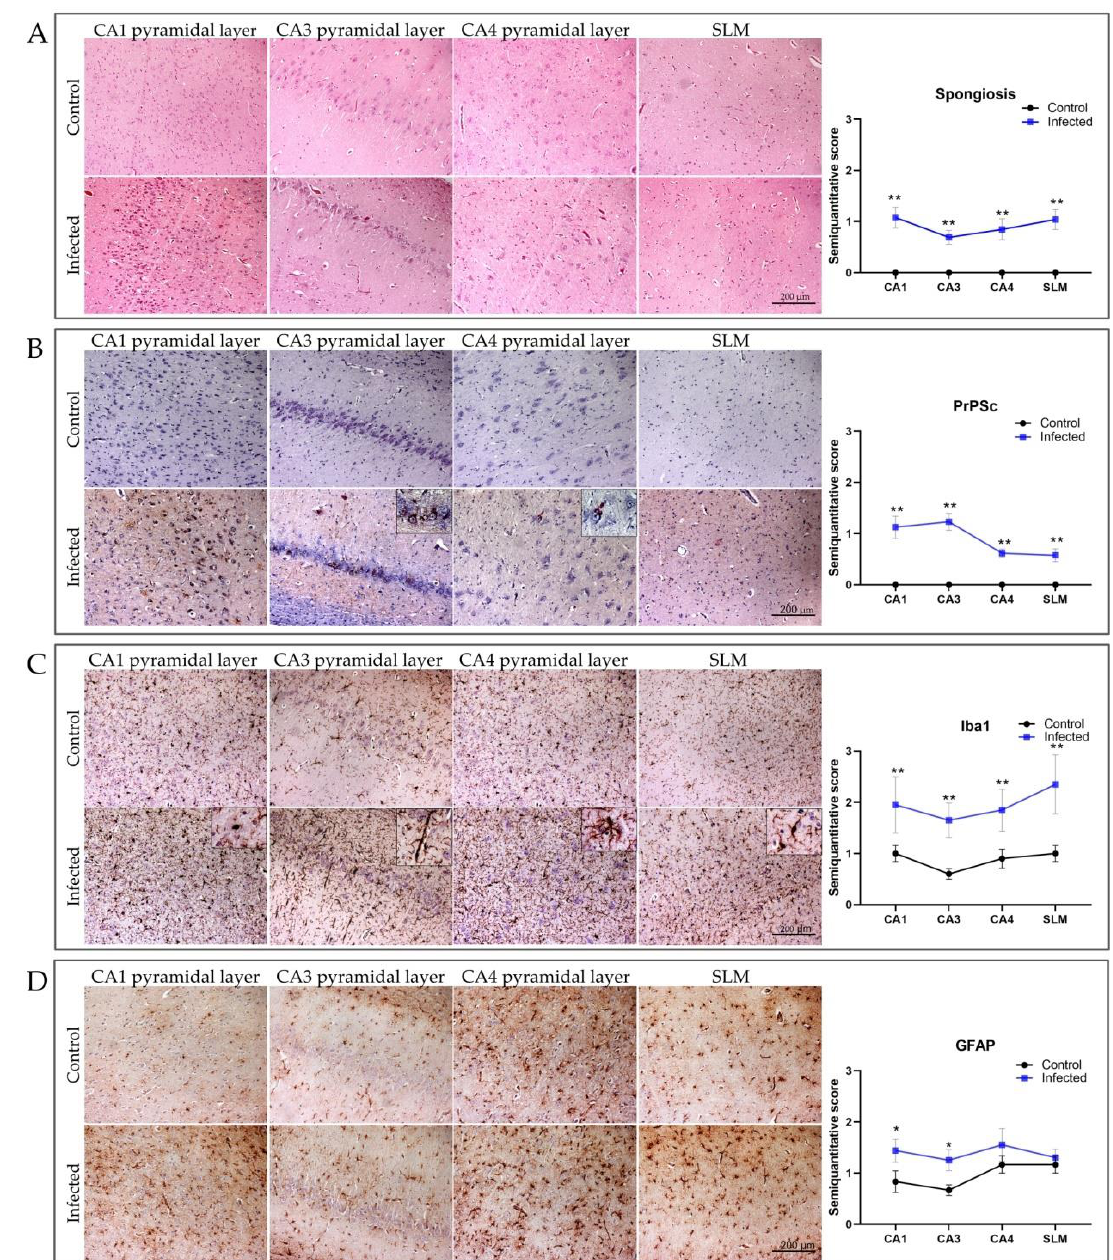
Figure 3. Distribution of neuropathological lesions (HE), PrP Sc deposition, astrogliosis (GFAP), and microgliosis (Iba1), in four different hippocampal regions in scrapie-infected and control sheep: pyramidal cell layers CornuAmmonis (CA) 1, 3, and 4, and the stratum lacunosum-moleculare (SLM). Graphs depict semi-quantitative assessment values for each parameter analyzed. ( A ) Mild spongiform changes were observed in all hippocampal regions analyzed. ( B ) Intraneuronal PrP Sc pattern (L42) in CA1, CA3, and CA4 and widespread fine granular PrP Sc pattern in the SLM. ( C ) Increased Iba1 staining in scrapie-infected versus control sheep. Magnified images show some of the morphological differences observed. ( D ) Signs of moderate reactive astrogliosis in scrapie-infected sheep compared with controls. Scores range from 0 (negative) to 5 (maximum intensity). Significant differences were determined using Student’s t -test or Mann–Whitney U test for normally and non-normally distributed data, respectively. * p < 0.05, ** p < 0.01. Scale bar = 200 µ